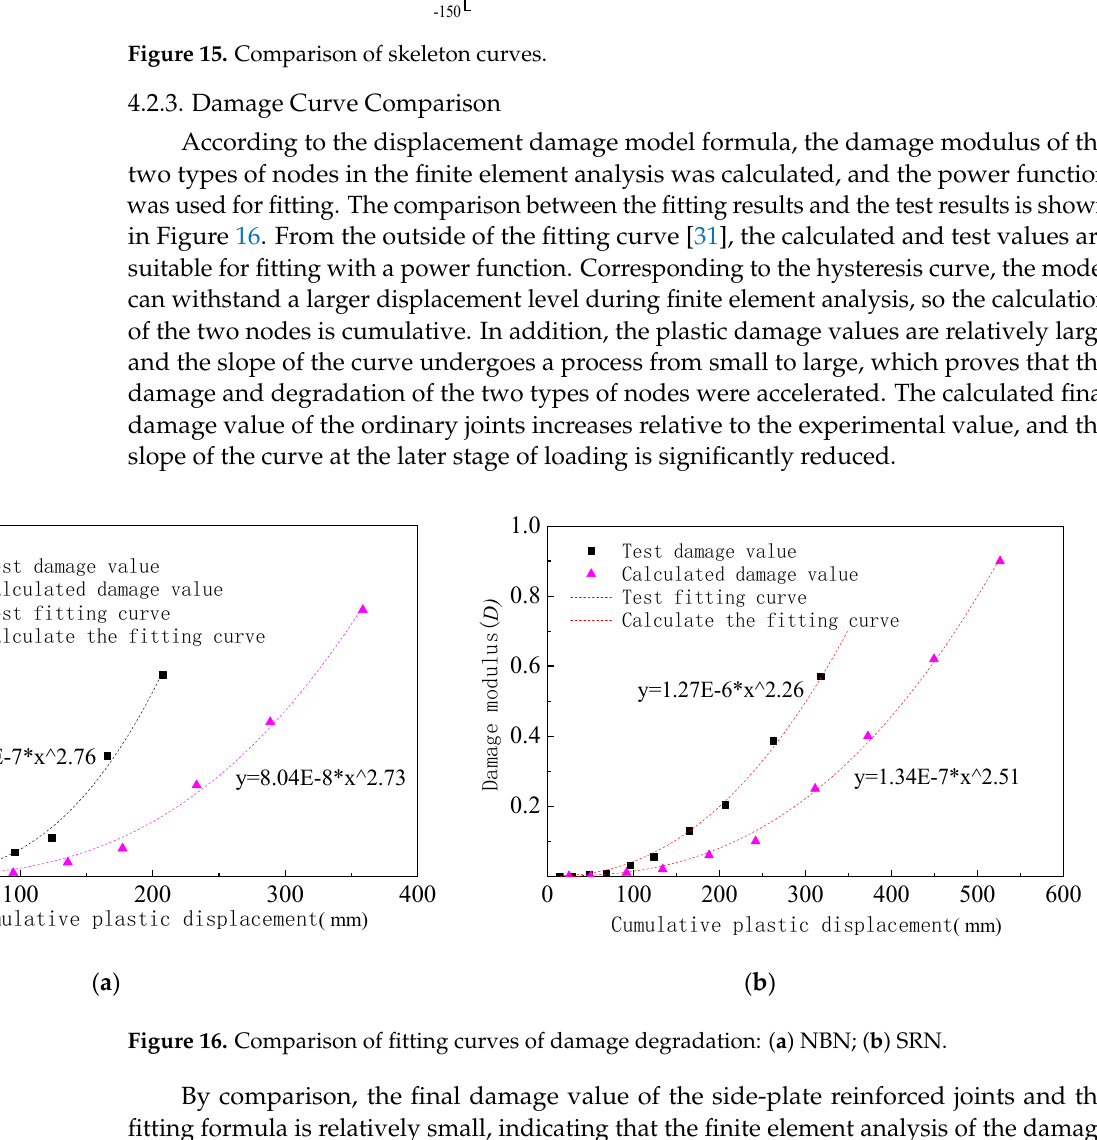
Figure 15. Comparison of skeleton curves.